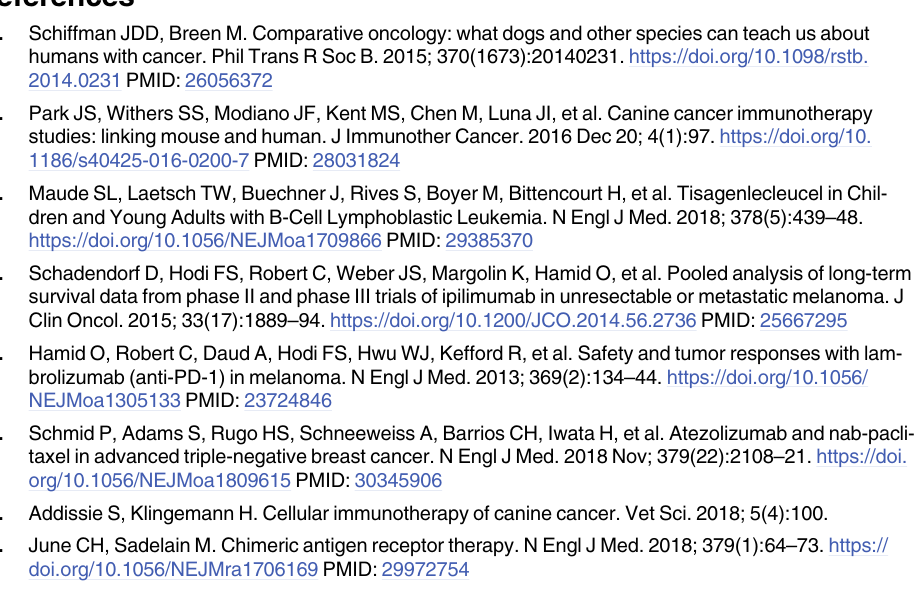
(Right). This was again compared to SA-AP treated blot (Left). Two blots using SA-AP and JC071 were prepared on separate